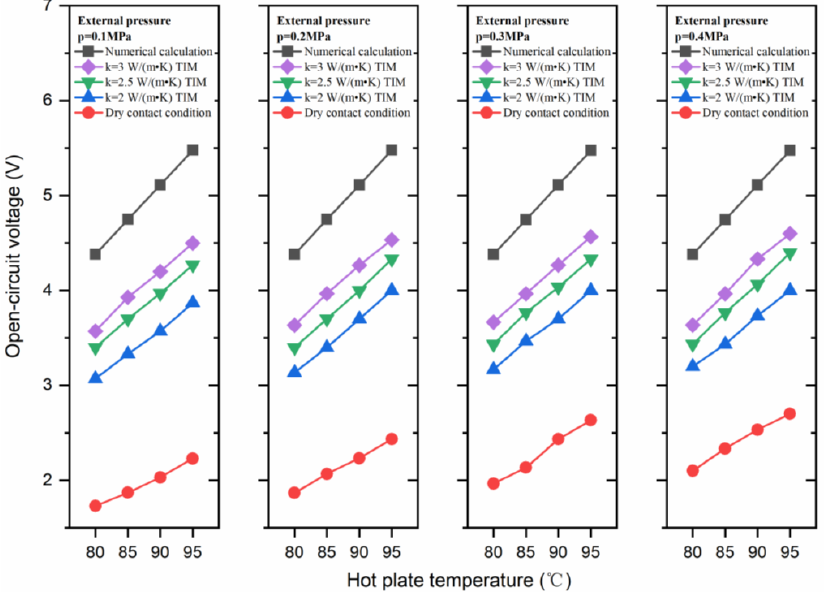
Figure 6. Effect of using thermal greases with different thermal conductivities as thermal interface Figure 6. E ff ect of using thermal greases with di ff erent thermal conductivities as thermal interface material on open-circuit voltage of TEG module. material on open-circuit voltage of TEG